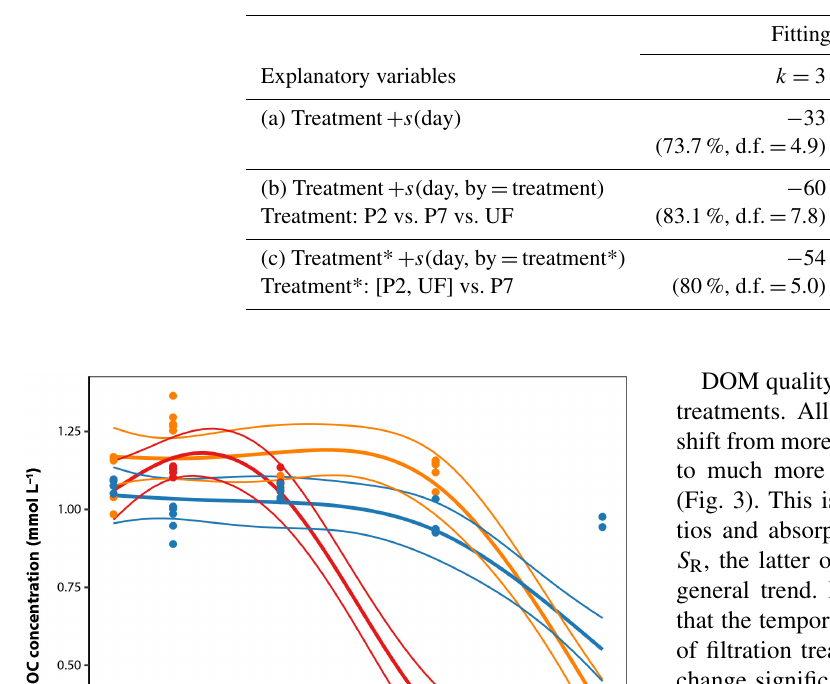
Table 1. Analysis of temporal DOC concentration dynamics. Three candidate GAM models were fit including a non-linear smoothing term s . These models correspond to the following scenarios: (a) treatments differ in initial concentration but show identical temporal dynamics; (b) treatments differ in initial concentration but with unique temporal dynamics of DOC concentration for each treatment; (c) treatments differ in initial concentration but with separate dynamics for P7 relative to P2 and UF. For each model two possible fitting parameters ( k ) were tested. Higher values of k allow more flexible model forms. Values reported are AIC with the percentage of deviance explained by the model in parentheses, followed by the estimated degrees of freedom. AIC is a measure of relative goodness of fit for each model to the observed data; lower AIC values indicate better fit. The best fit model is printed in bold and was used to generate the non-linear regression lines in Fig. 1.